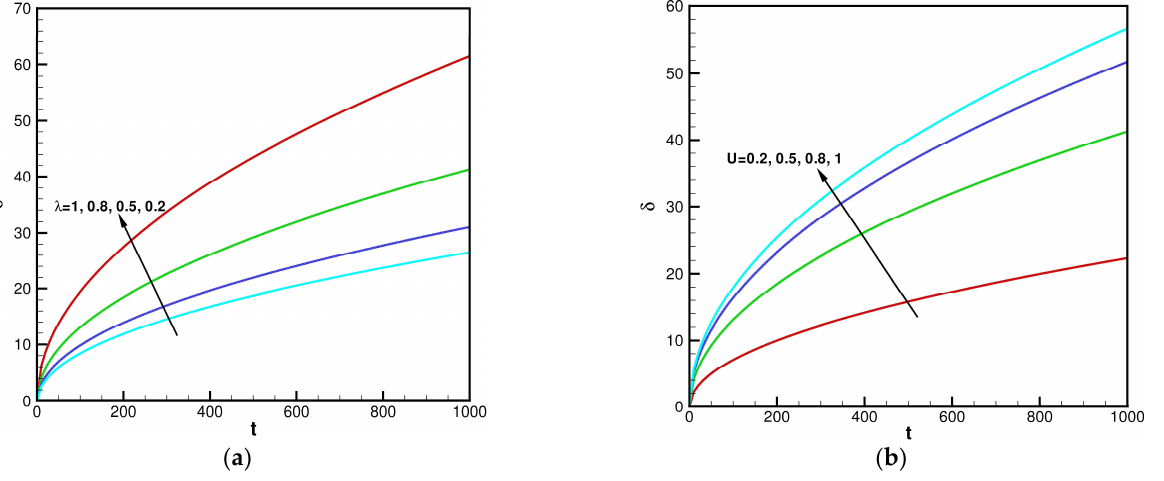
Figure 4. The distributions of the non-dimensional transient distance δ ( t ) of moving boundaries: ( a ) comparisons of the transient distance of moving boundaries depending on various values of λ when U = 0.5; ( b ) comparisons of the transient distance of moving boundaries depending on various values of U when λ =